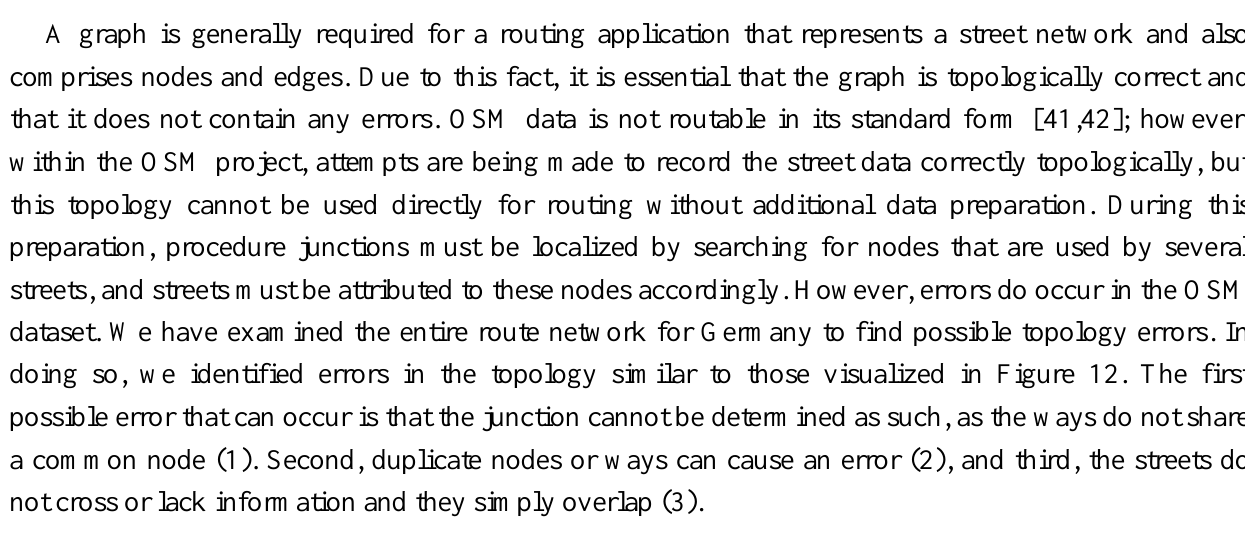
Figure 12. OSM Topology Error